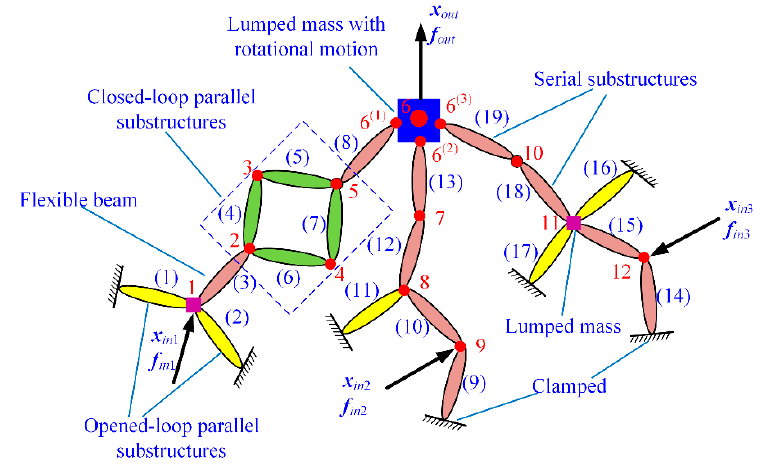
Figure 5. General topology of typical compliant mechanisms.